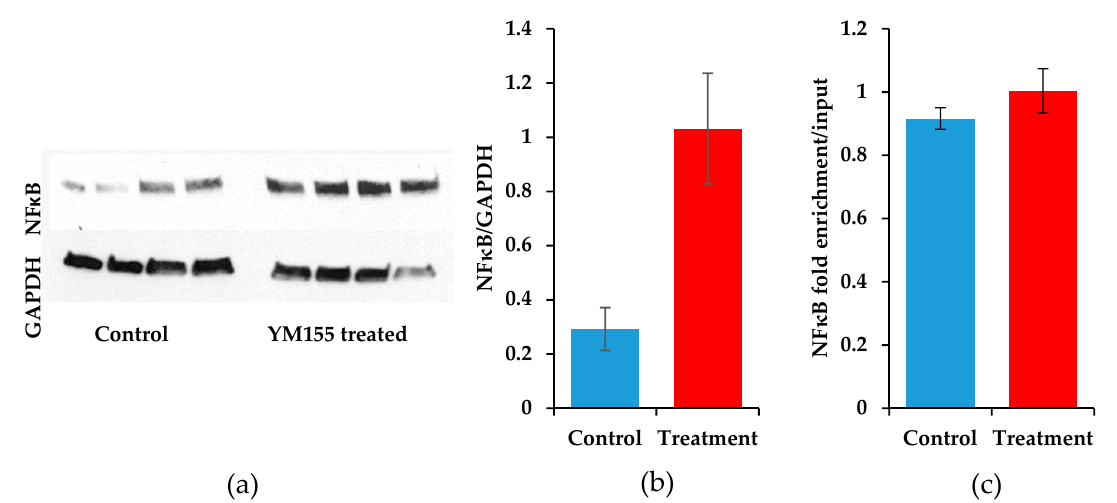
Figure 8. NF κ B expression and Birc5 promoter binding in response to YM155. ( a ) Immunoblots of NF κ B expression (top) and GAPDH (bottom) in control and YM155 treated mice after 11 days. ( b ) Quantification of band intensities of NF κ B normalized to GAPDH expression, error bars for samples are SEM ( p = 0.015). ( c ) ChIP-qPCR for NF κ B demonstrates near equal levels at the Birc5 promoter between the YM155 treated HS-SY-II samples ( n = 3) compared to controls ( n = 3), error bars for treated samples are SEM ( p = 0.32).